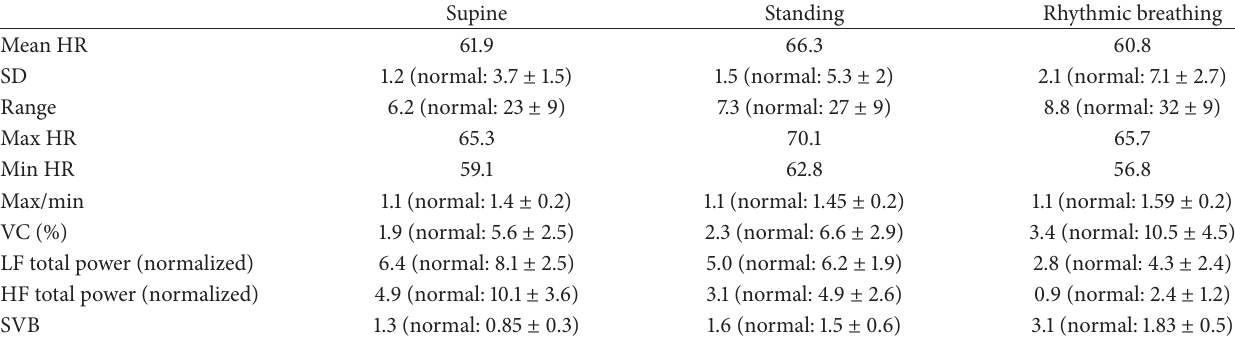
Table 1: Heart rate variability in the time and frequency domains.